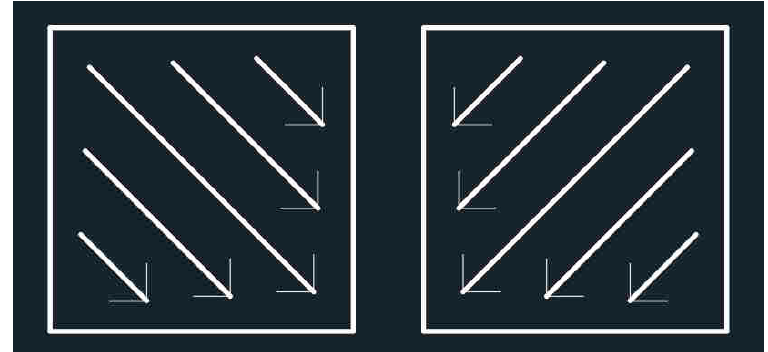
Figure 3. The scan pattern of selective laser melting (SLM).